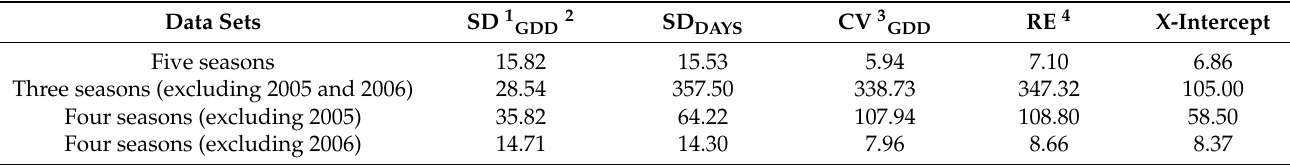
Table 1. Base temperature (°C) estimation for “Flame Seedless” table grape between bud break and harvest using five different methods and based on different sets of seasons.